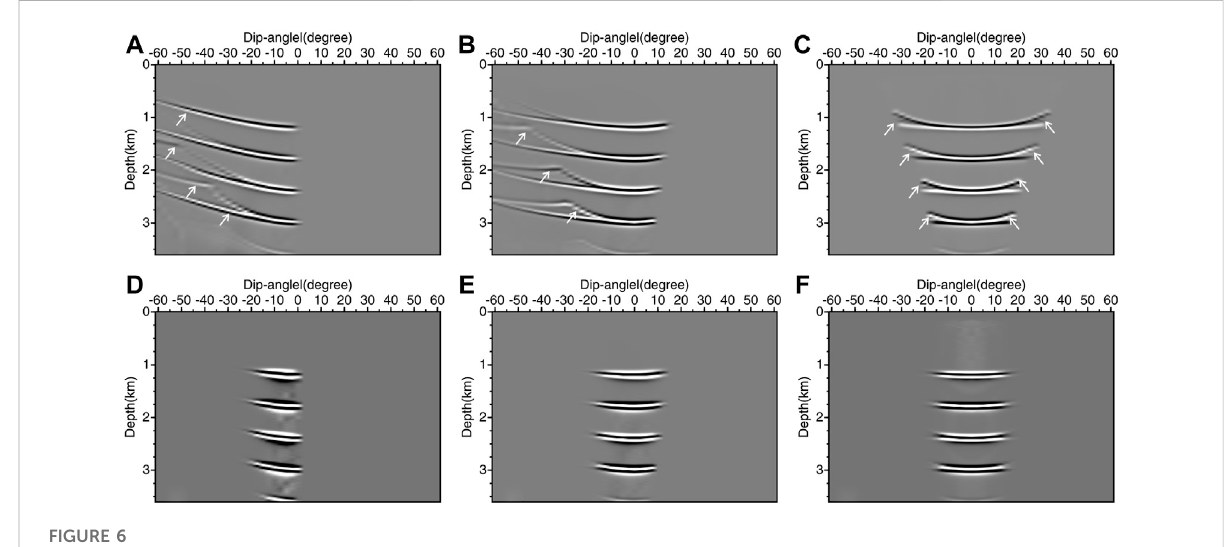
FIGURE 6 The DDCIGs of the layer model data produced by DDGRT at the lateral position of (A) x = 1,000 m, (B) x = 1,500 m, and (C) x = 2000 m. (D – F) are the DDCIGs produced by weighted DDGRT at the same lateral